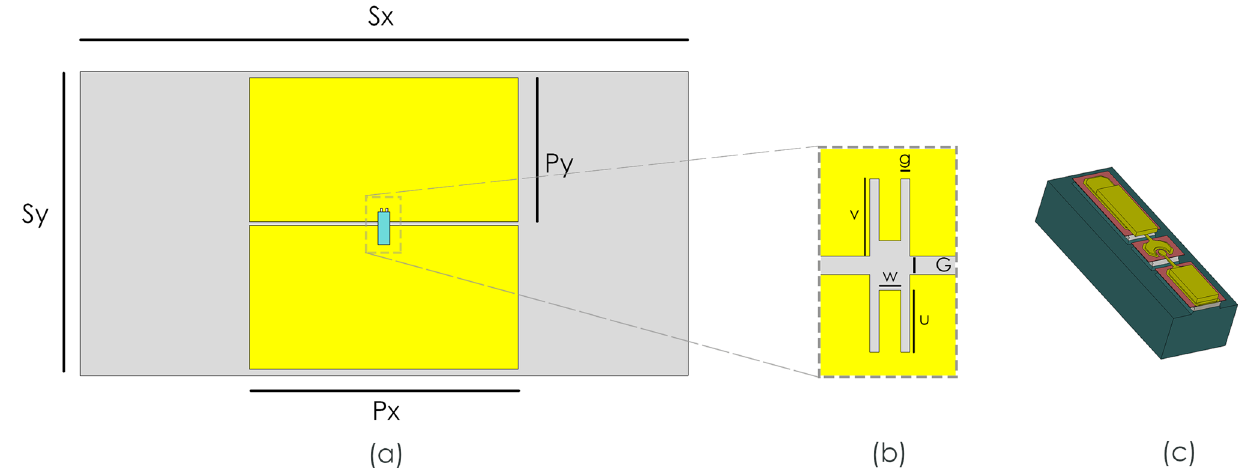
Figure 1. A schematic of an air bridged Schottky diode controlled phase shifting unit cell. ( a ) Schematic of the front view of the proposed unit cell, with quartz thickness 0.2 mm with ground plane backing. ( b ) The diode bonding site, designed to have minimal effect on EM performance, whilst allowing for flip-chip bonding of the diode. ( c ) The full 3D model of the GaAs